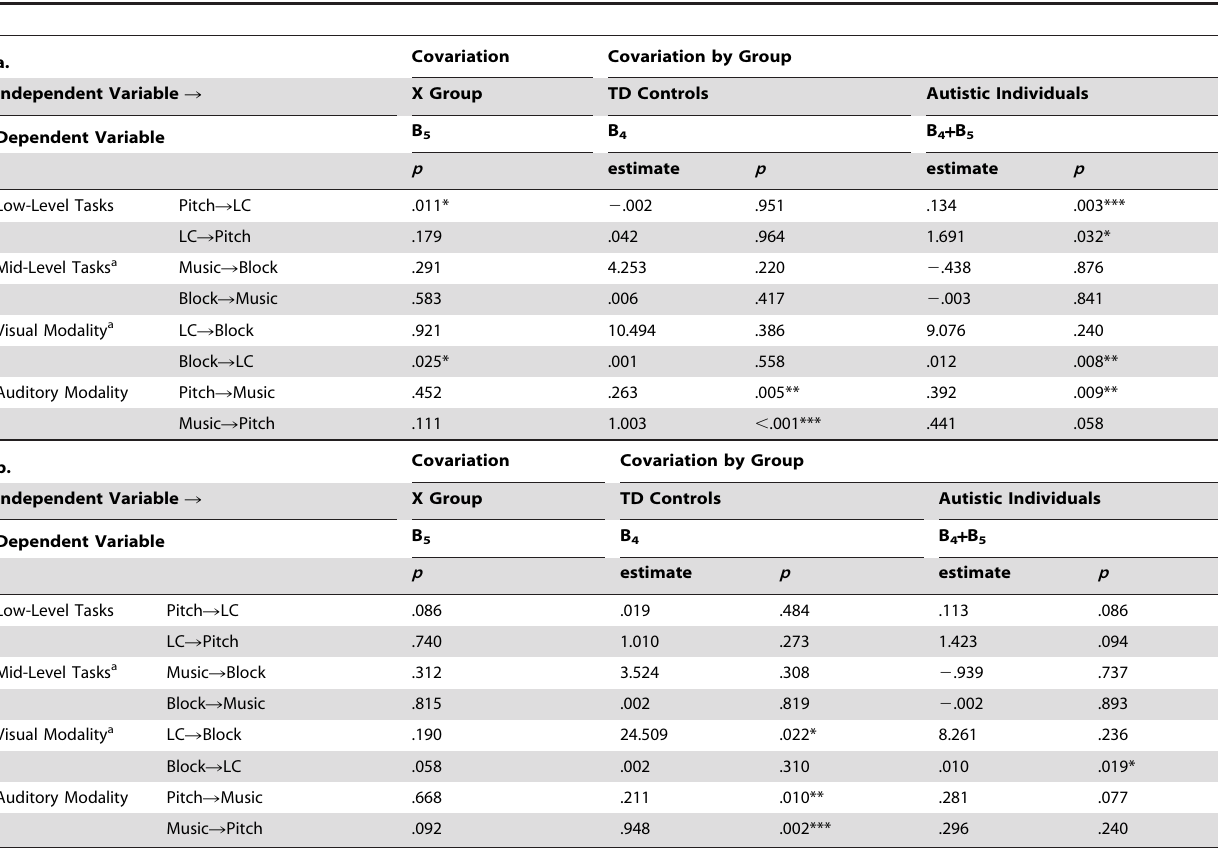
Table 4. Model 2 (Between group differences in residual covariation) main results: a. Wechsler’s Full Scale IQ (FSIQ), or b. Raven Progressive Matrices